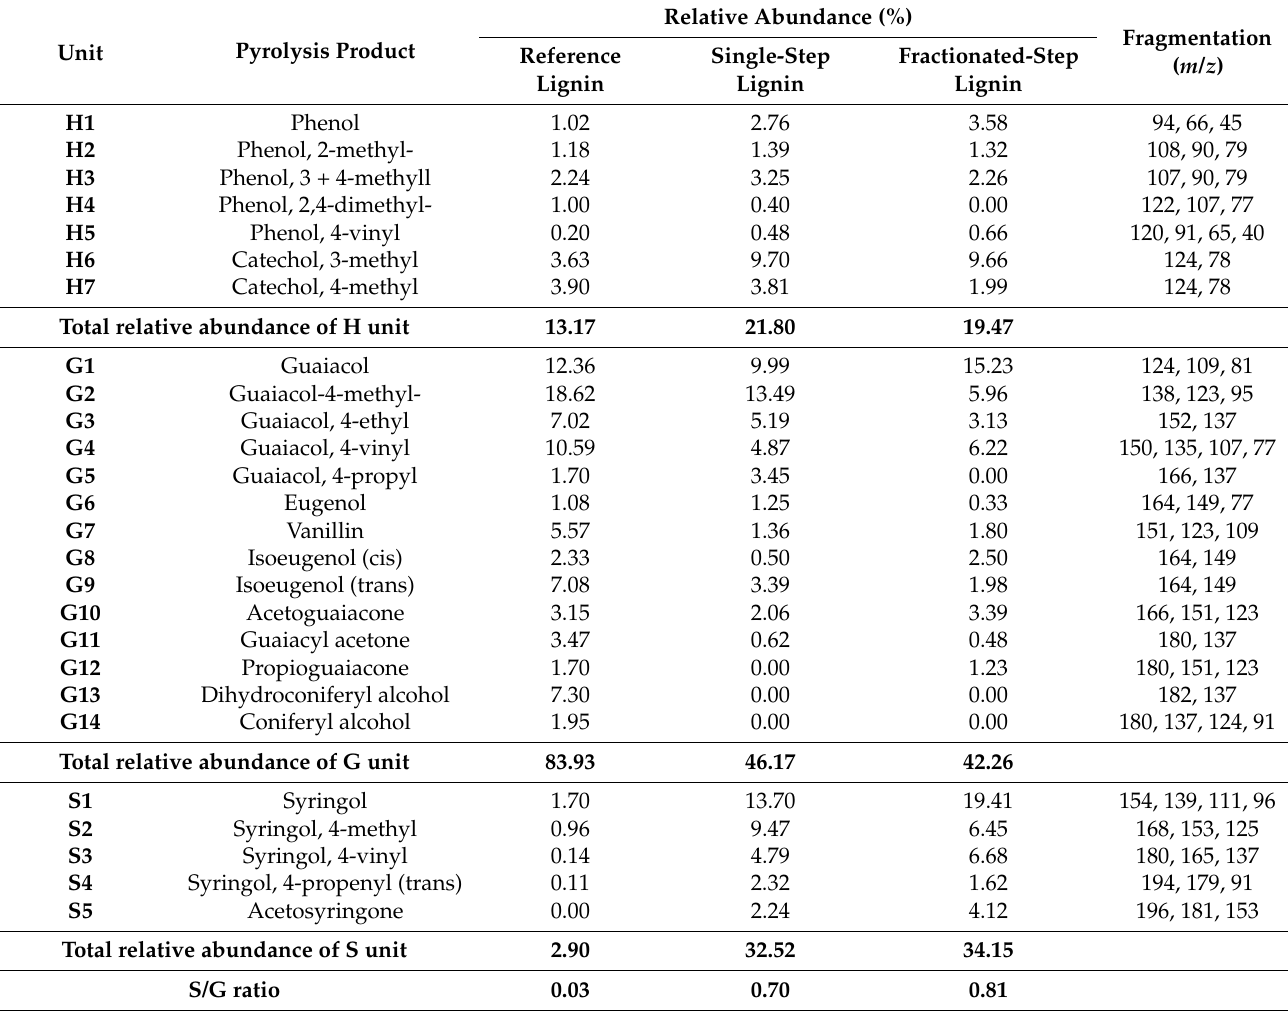
Table 3. The list of pyrolysis product reference lignin, single-step lignin, and fractionated-step